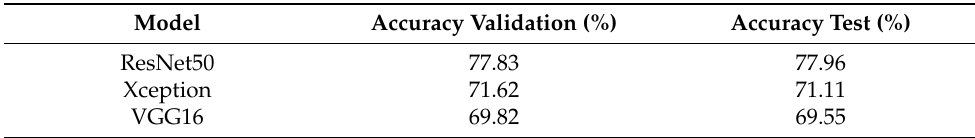
Table 3. Prediction of trust through images.